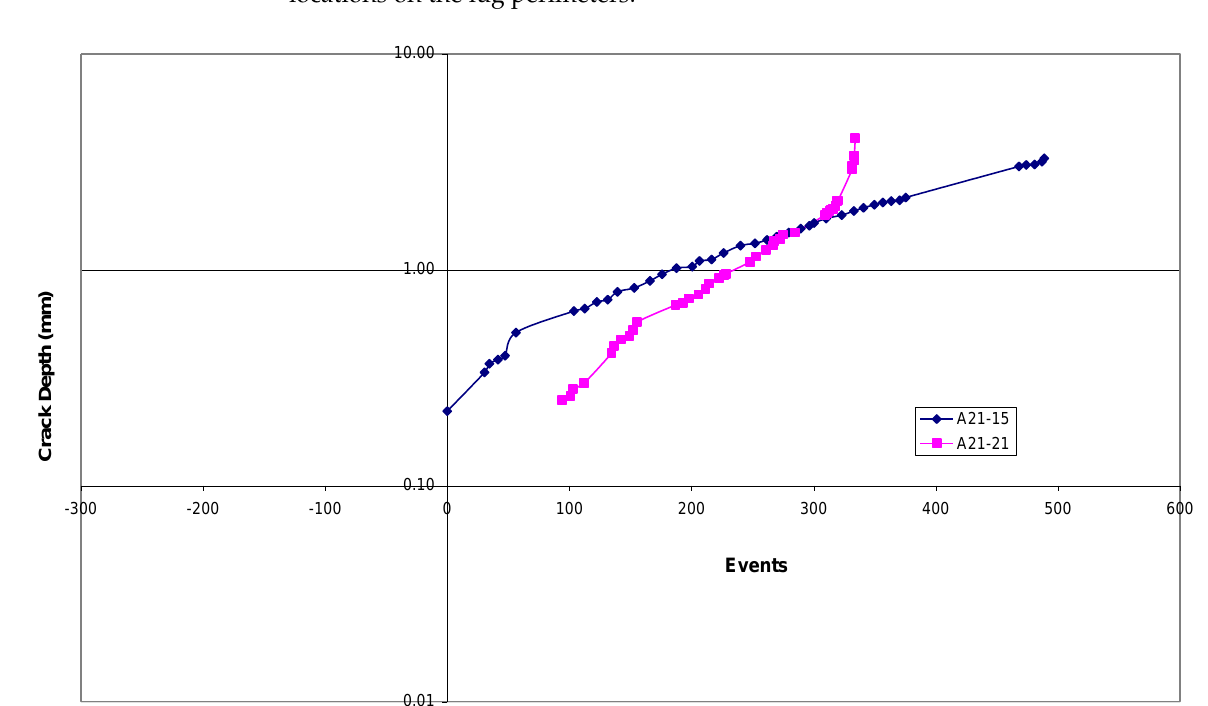
Figure 14. Fatigue crack growth plots for the A21-015 and A21-021 TEF hinge lugs: adapted from [46].